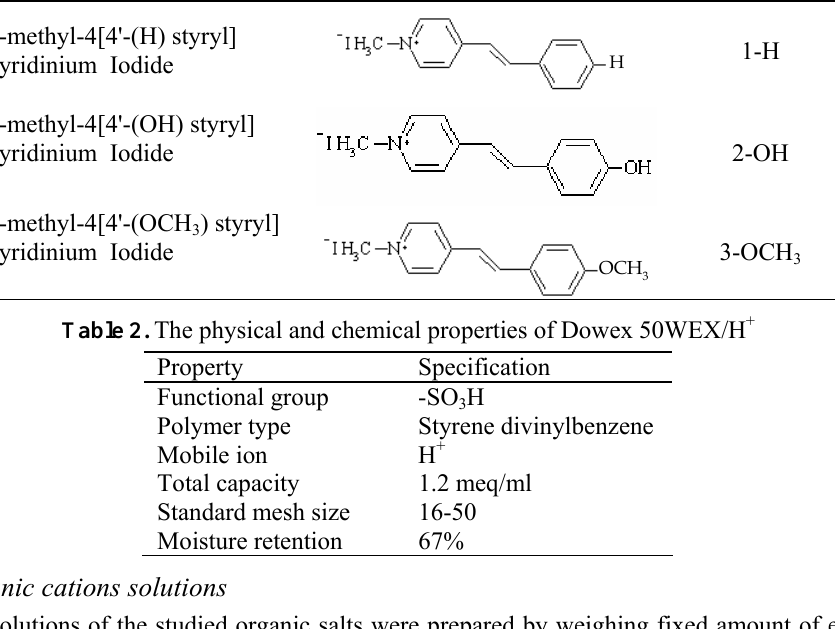
Table 1. Names, structures and abbreviations of the studied organic salts Name